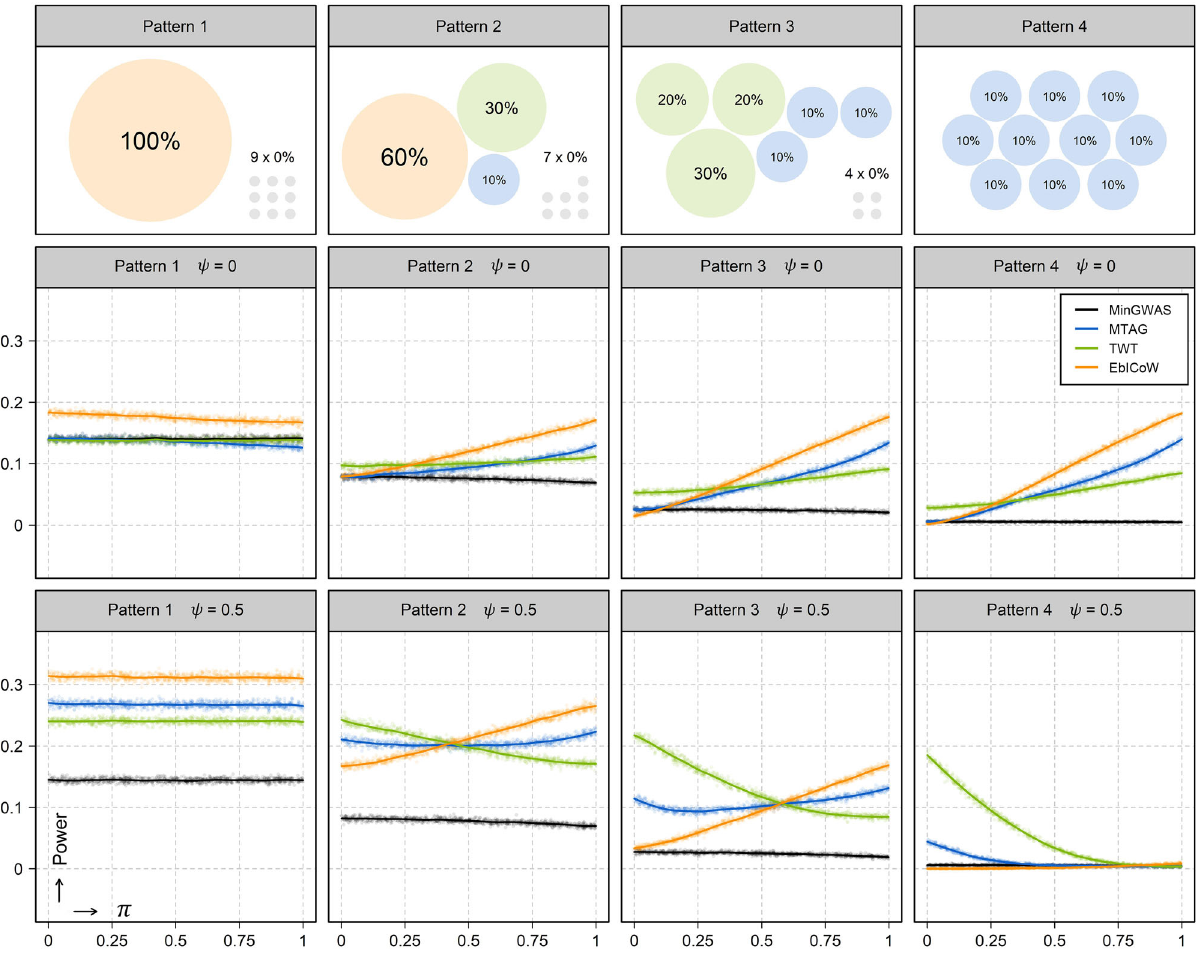
Fig. 2 | Power comparison between EbICoW, MTAG and TWT via simulations. The summary statistics of ten GWASs were simulated, each consisting of 50,000 SNPswith 10%having true effect. We evaluatedthe power ofEbICoW,MTAG, TWT andMinGWASat α =0.05/50,000undertwodifferent ψ 2 {0,0.5}andfourdifferent patterns of true effect. For pattern 1, one GWAS with true effect E( χ 2 ) = 2 and nine GWASsunderthenullE( χ 2 )=1weresimulated;forpattern2,threeGWASswithtrue effect E( χ 2 ) 2 {1.6, 1.3, 1.1} and seven GWASs under the null were simulated; for pattern3,sixGWASswithtrueeffectE( χ 2 ) 2